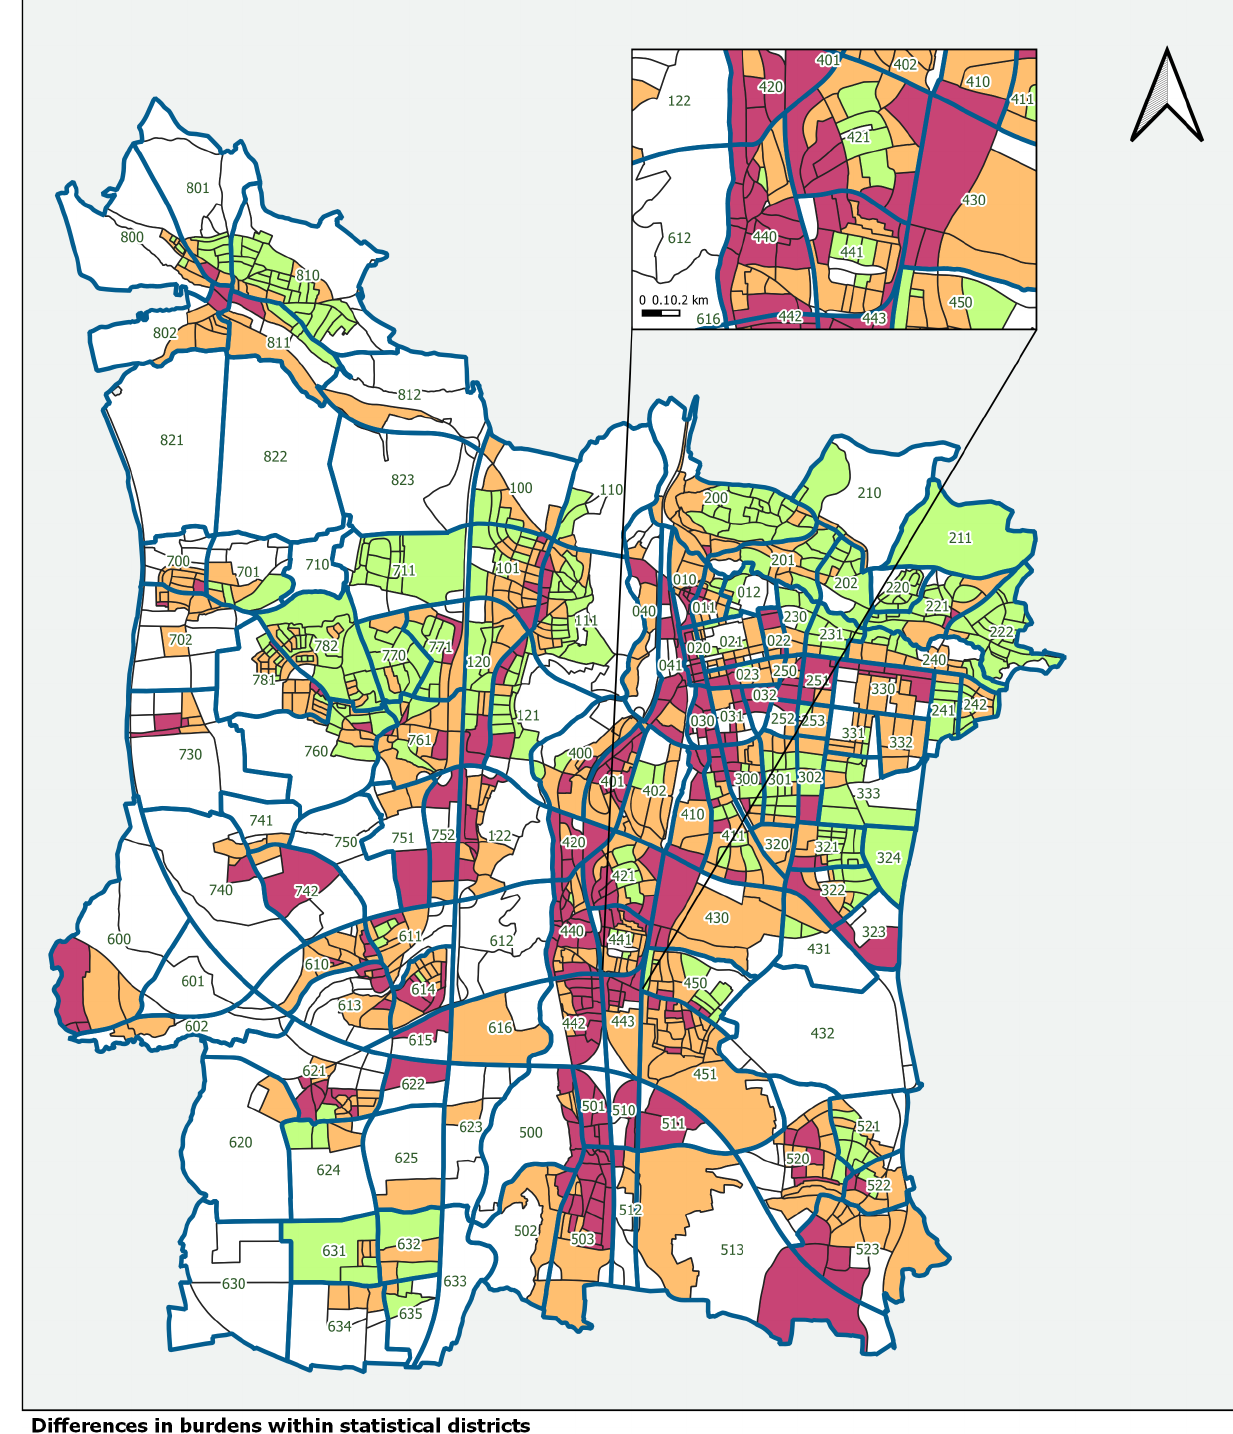
Figure 1. Multiple‐burden map of